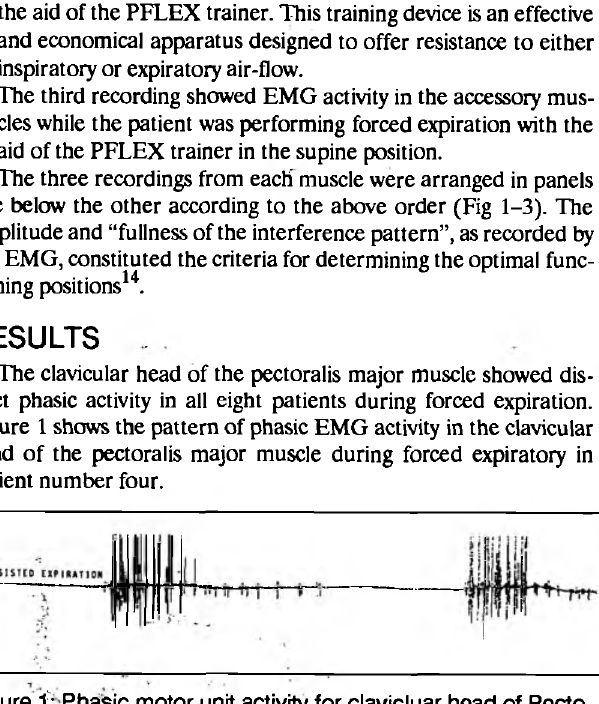
Figure f: phasic motor unit activity for clavicluar head of Pecto- ralis Major during forced expiration with the subject in supine